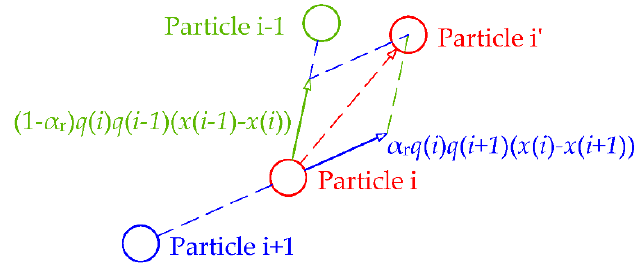
Figure 4. Graphical representation of new movement rule.